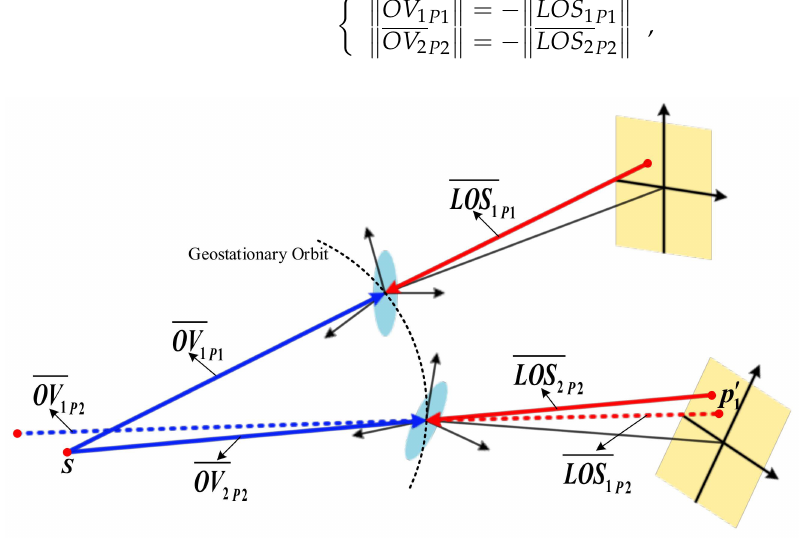
Figure 3. The schematic diagram of relative